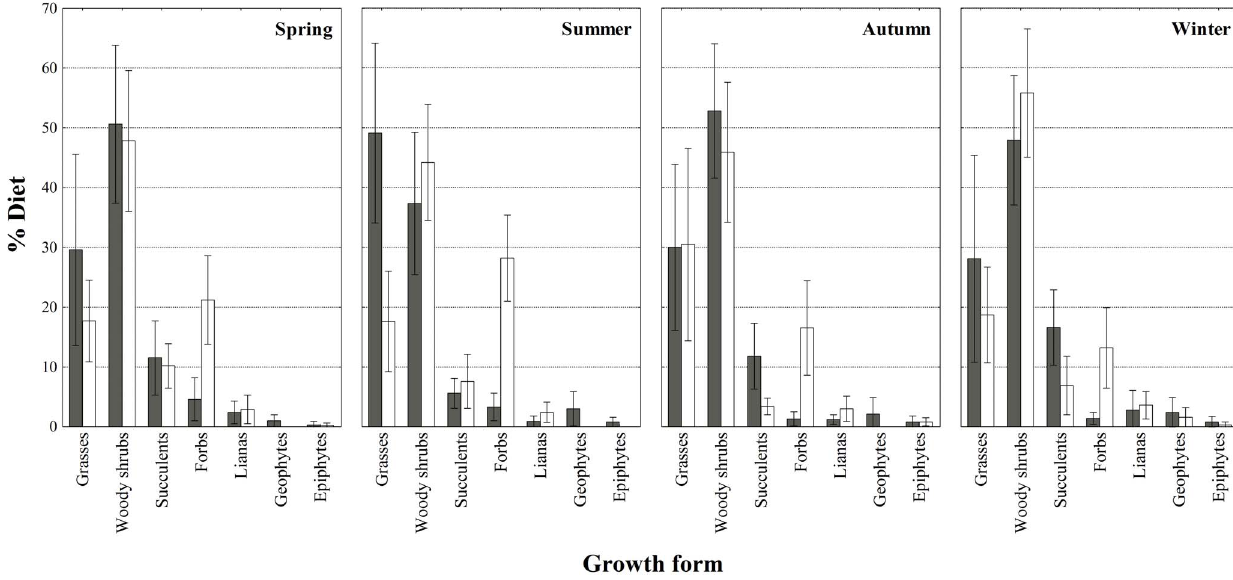
Figure 2. Seasonal diet, grouped into broad growth form categories (mean ± SD), of elephant (shaded bars) and black rhinoceros (clear bars) in the Addo Main Camp section.